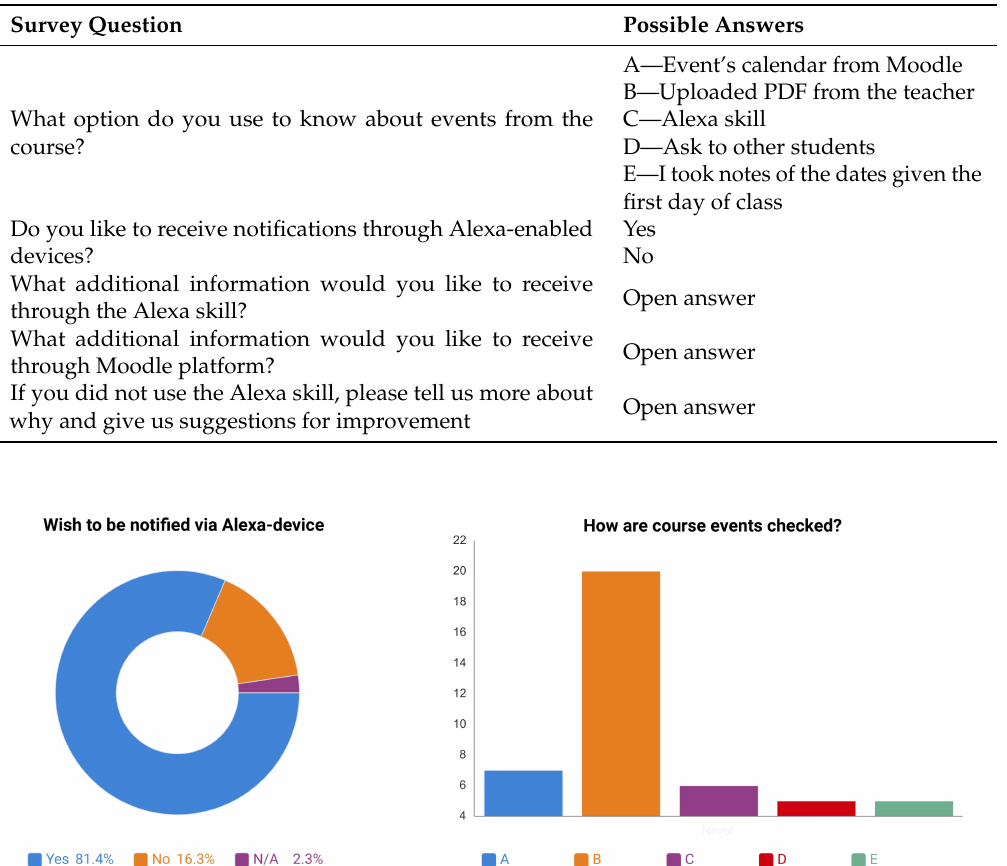
Table 4. Feedback survey to students (Extract taken from Saiz-Manzanares et al. [23]).